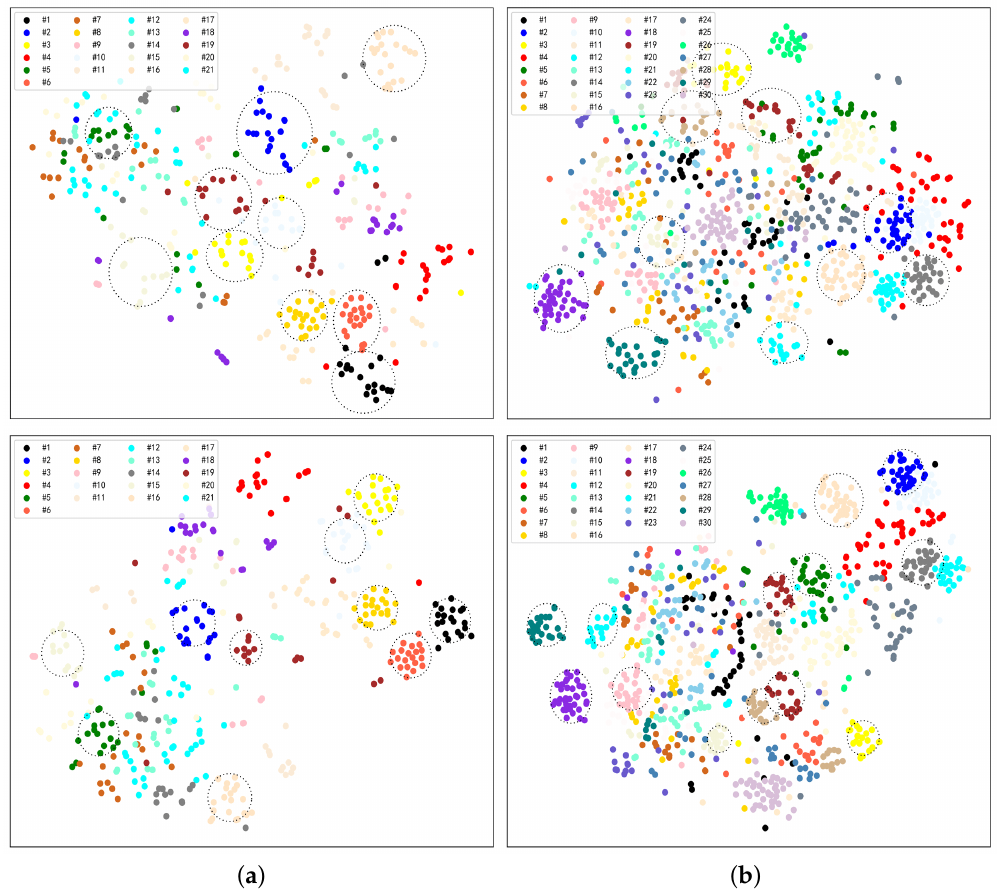
Figure 7. Visualization results of different datasets. ( a ) UCM dataset. ( b ) AID dataset. The top figures show the features before selection and the bottom figures show the features after selection.